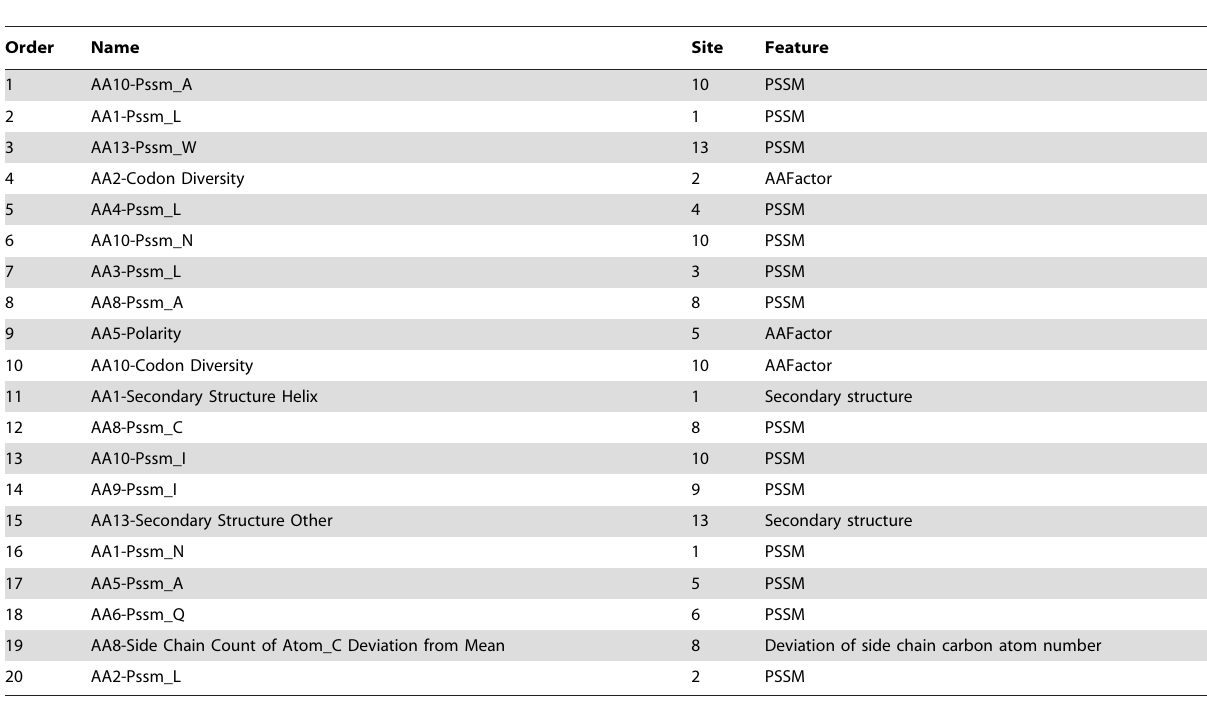
Table 1. Top 20 features of the optimal feature set for pyrrolidone acid modification sites.